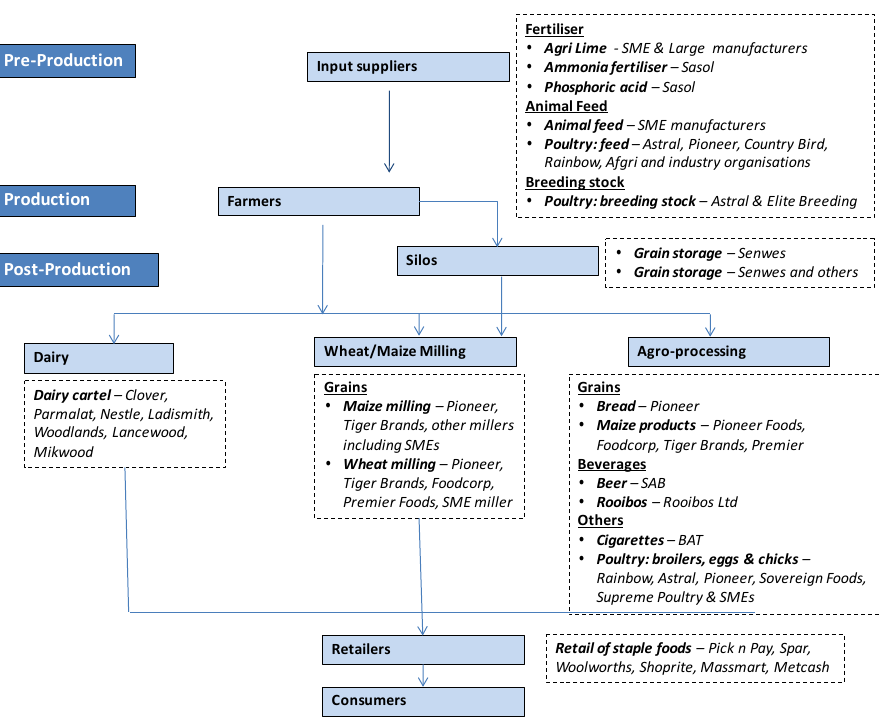
FIGURE 4: Cases considered in the agri-food value chain Source: Compiled by